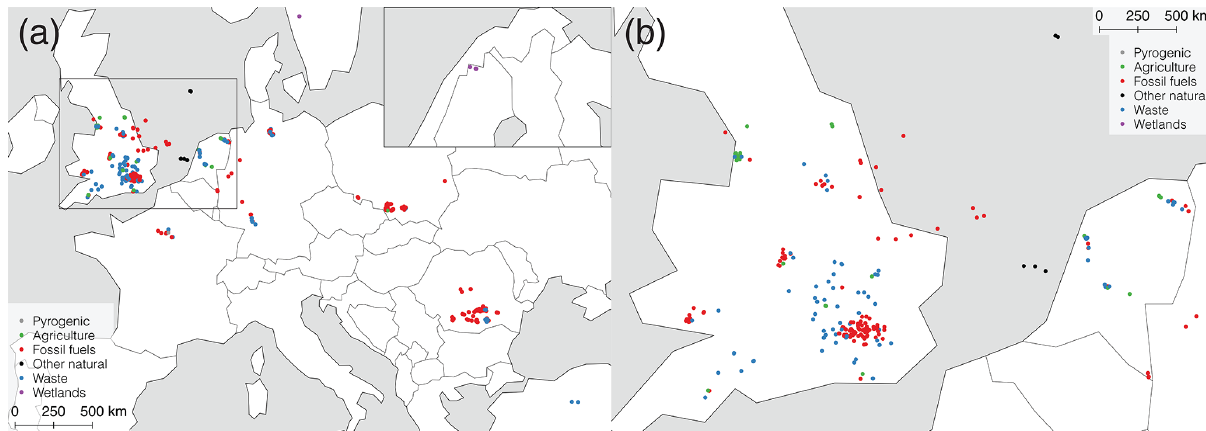
Figure 1. Geographical distribution of isotopic signature measurements ( δ 13 C and/or δ 2 H of CH 4 ) carried out within the MEMO 2 project (2017 to 2020), depending on the type of source. (a) All locations. (b) Only in the UK, the Netherlands, and Germany.